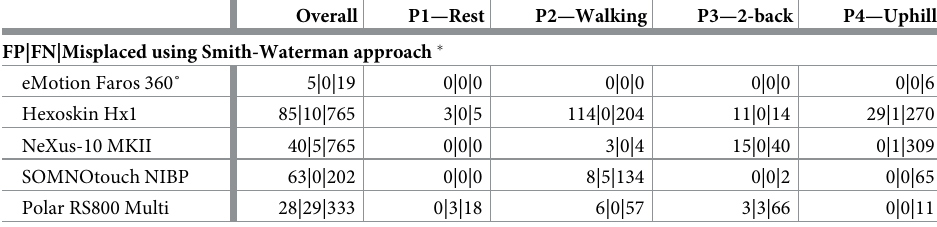
Table 5. QRS detection performance through RR interval alignment using the modified Smith-Waterman algo- rithm for numericals. Errors are expressed by false positive counts (FP), false negative counts (FN), and the number of misplaced annotations from unsynchronized data (50 ms